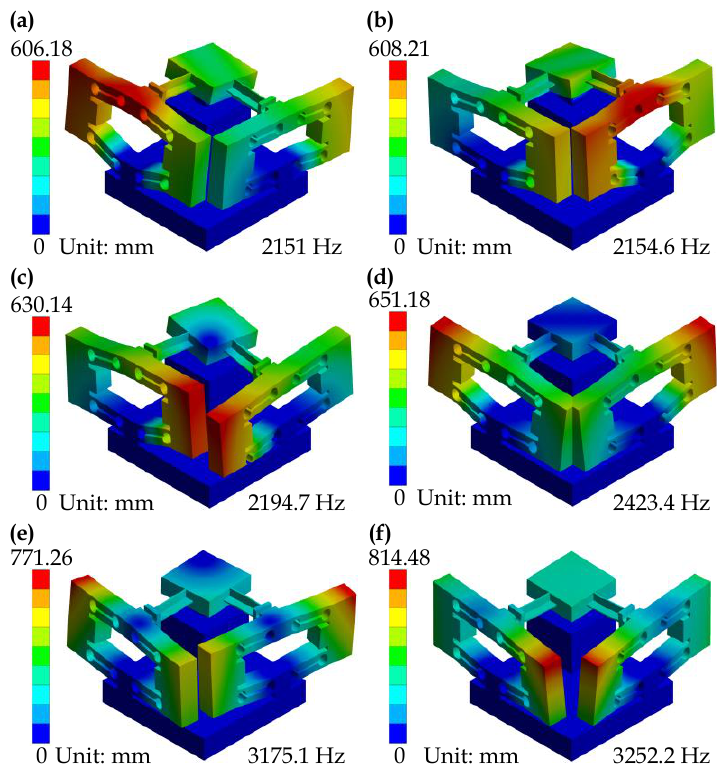
Figure 8. Modal analyses of proposed 2-DOF decoupled stage without loads. ( a ) Total deformation in the first mode (2151 Hz). ( b ) Total deformation in the second mode (2154.6 Hz). ( c ) Total deformation in the third mode (2194.7 Hz). ( d ) Total deformation in the fourth mode (2423.4 Hz). ( e ) Total deformation in the fifth mode (3175.1 Hz). ( f ) Total deformation in the sixth mode (3252.2